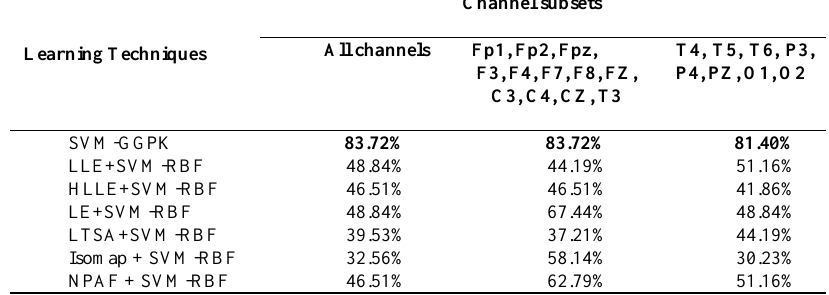
Table 6. Accuracy of SVM with RBF kernel trained on features extracted using LLE, HLLE, LE, LTSA, Isomap, and NPAF on different subsets of EEG signal of ADHD and BMD patients at eye-closed resting condition. Channel subsets